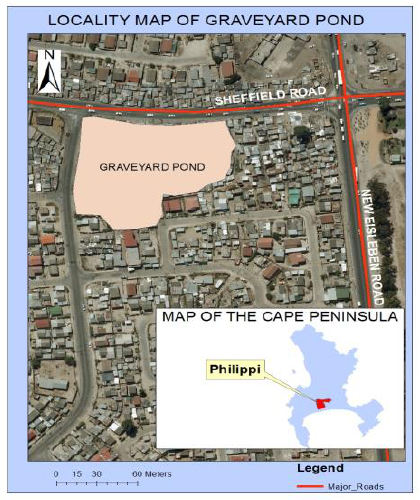
Figure 1. Locality Map of Graveyard